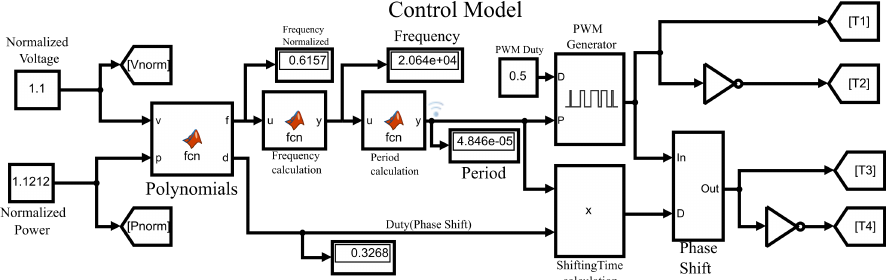
Figure 9. Illustration of Simulink model with normalized voltage and normalized power as